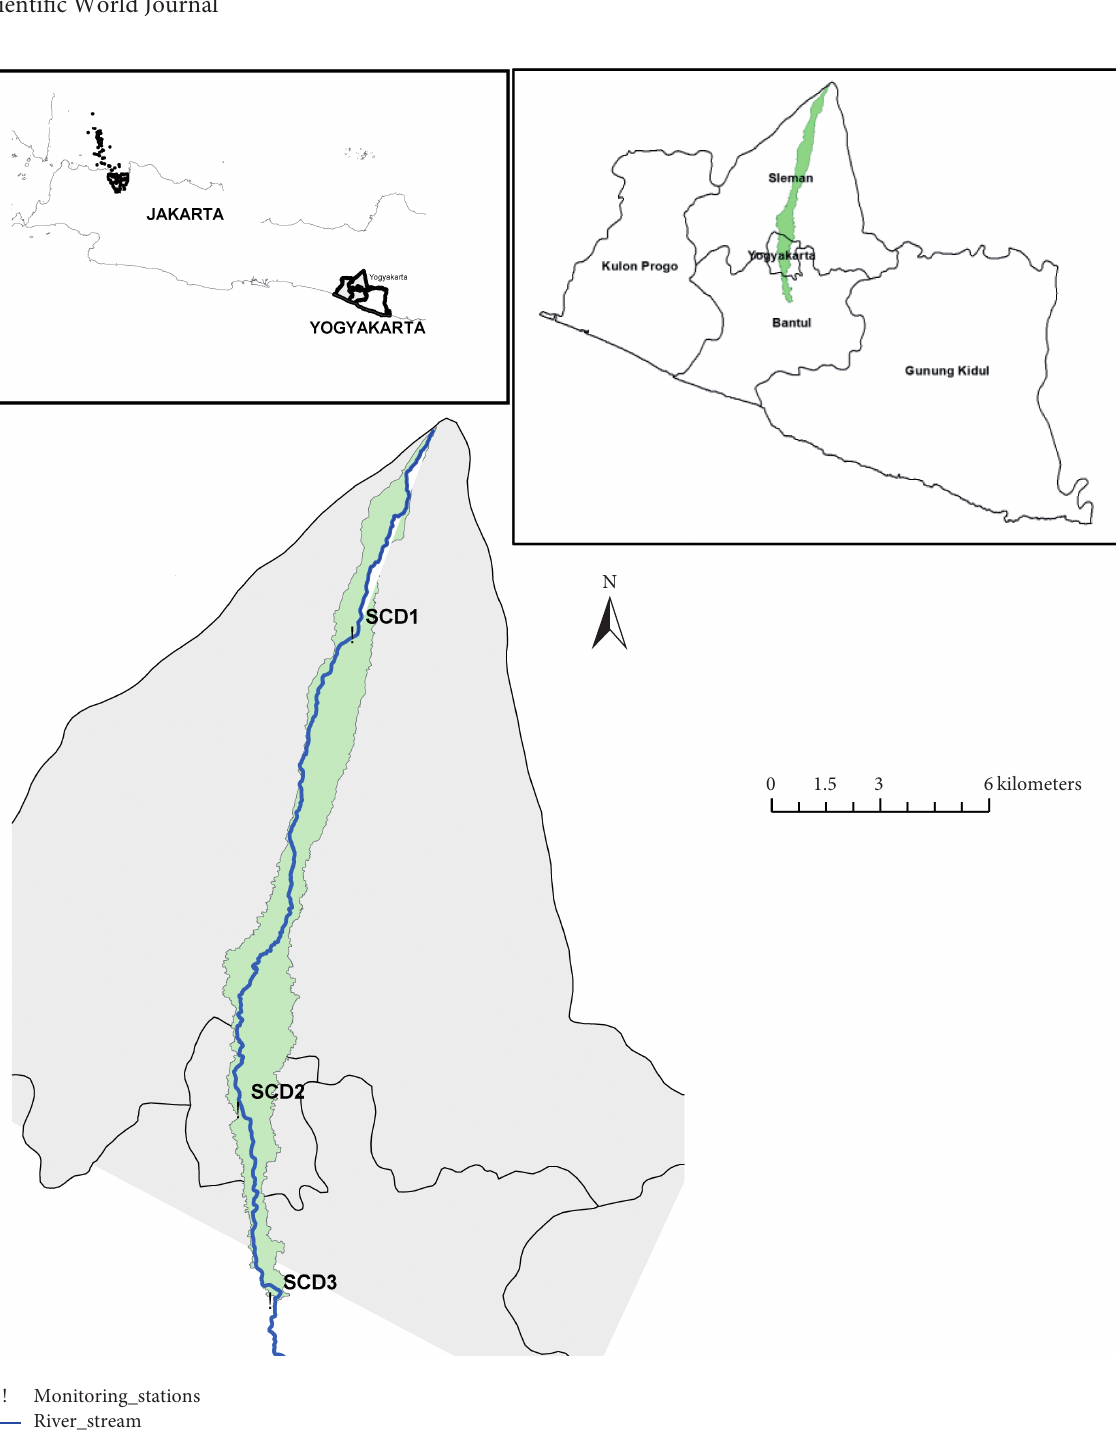
Figure 1: Code River watershed and water quality monitoring